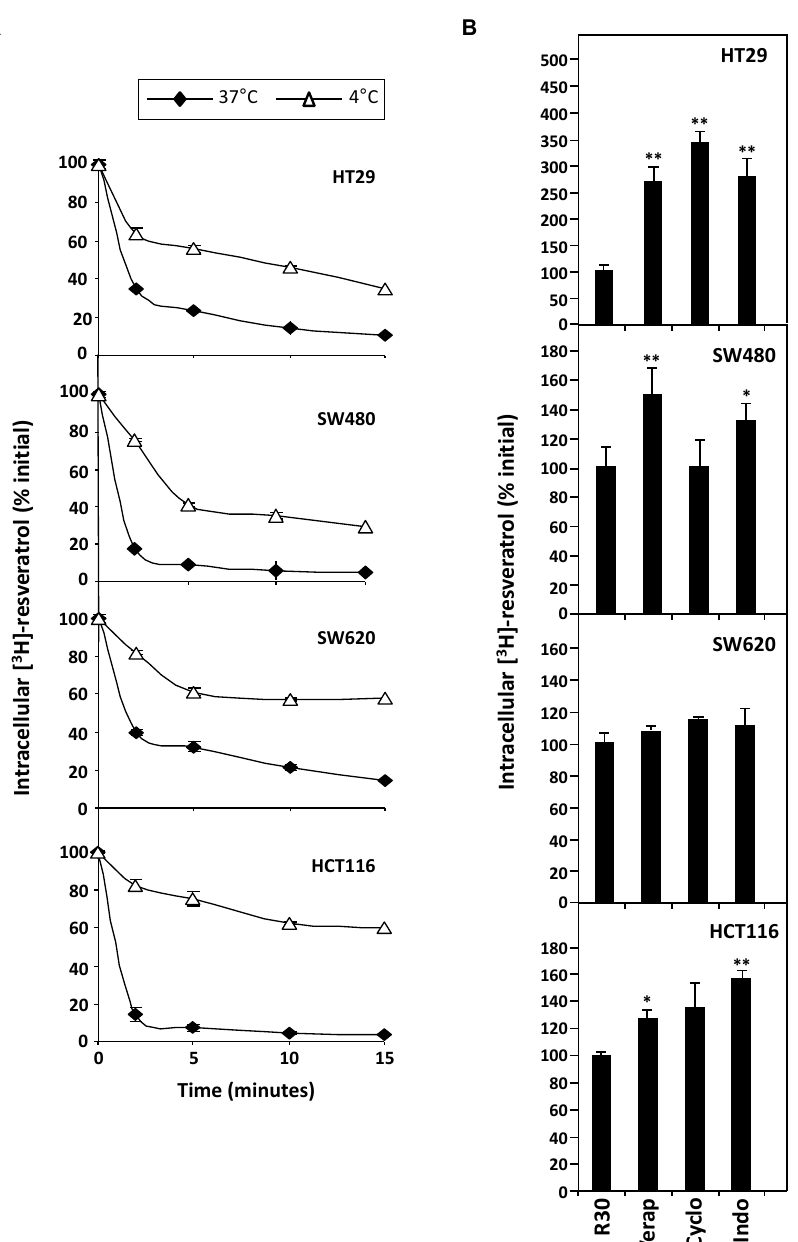
Figure 3. Involvement of active process in the e ffl ux of tritiated resveratrol in human colon carcinoma cells. ( A ) SW480, HT29, SW620, and HCT116 cells were submitted to time course measurement of [ 3 H] resveratrol e ffl ux. Cells were grown in 6-well plates until confluence and treated for 10 min with 30 µ M of [ 3 H] resveratrol (uptake phase). Cells were then quickly washed with PBS 1X and [ 3 H] resveratrol was allowed to e ffl ux in fresh medium at 37 ◦ C and 4 ◦ C for indicated times. Cells were lyzed and radioactivity levels were determined and plotted as percentages of initial levels measured after uptake phase. Results are statistically di ff erent between 37 ◦ C and 4 ◦ C e ffl ux experiments with p -value at least < 0.05 by Student’s test. ( B ) Confluent colon cancer cells were pretreated for 10 min with e ffl ux pumps inhibitors, 20 µ M verapamil (Vera), 20 µ M cyclosporine A (Cyclo), or 20 µ M indomethacin (Indo). They were then submitted to 10 min of [ 3 H] resveratrol uptake, washed and e ffl ux phase was conducted for 5 min in 37 ◦ C fresh medium. Resveratrol levels are expressed as percentages of intracellular radioactivity in untreated cells. Data are means ± SD (n = 3) of a representative experiment among three independent ones. * p < 0.05 and ** p < 0.01 by Student’s test.